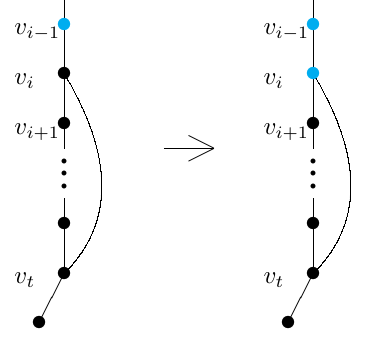
Fig. 3: Recolouring in Case